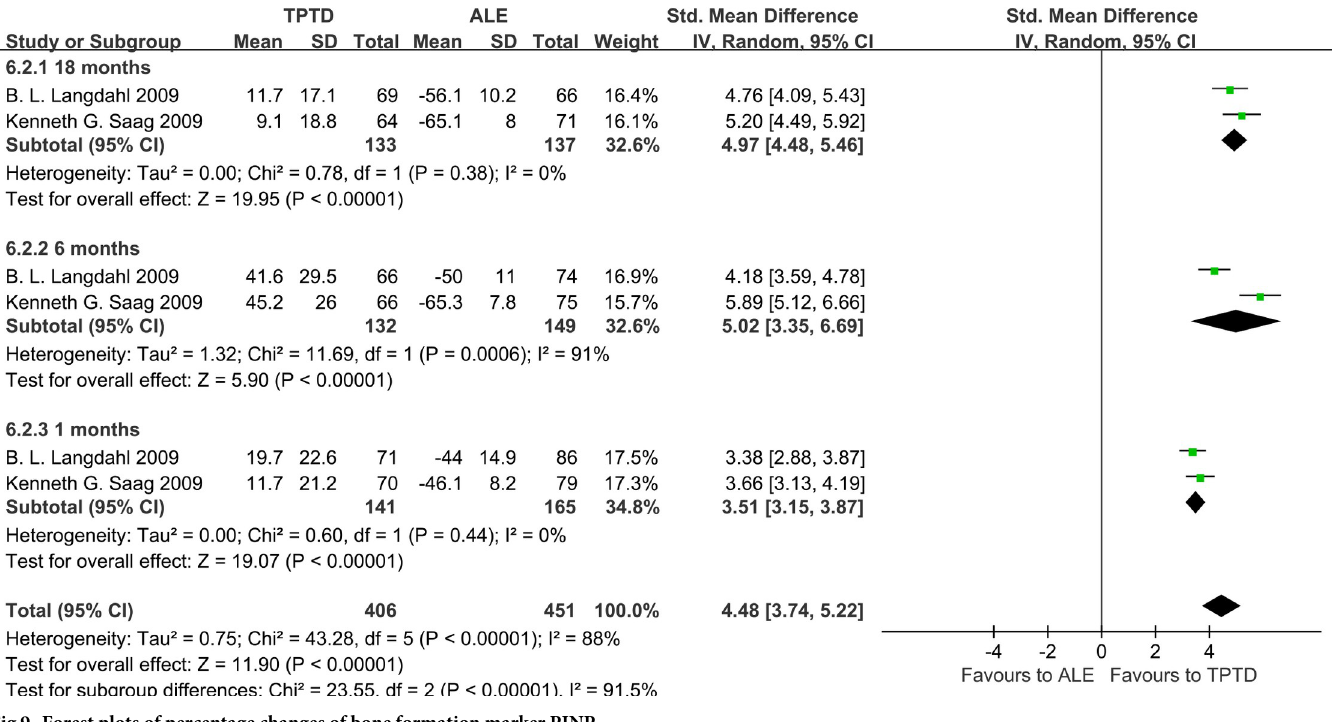
Fig 9. Forest plots of percentage changes of bone formation marker PINP.